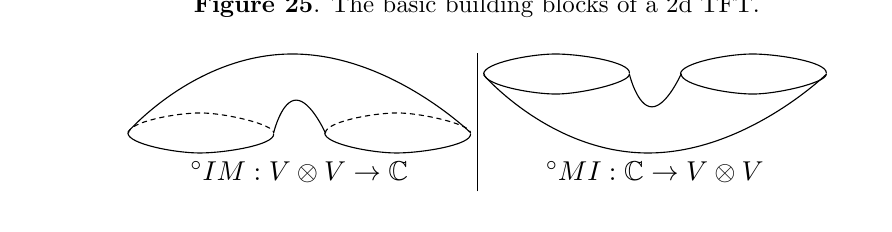
Figure 26 . The pairing of V with itself.